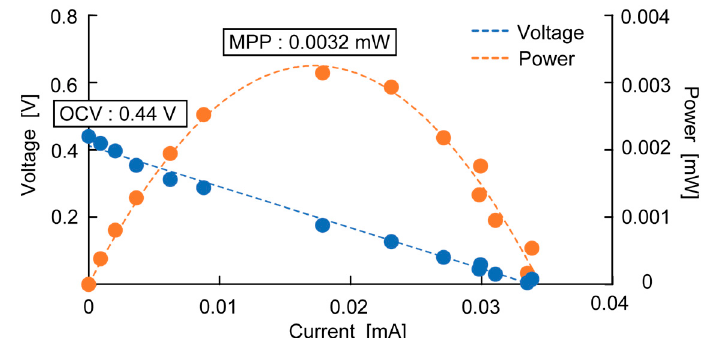
Figure 4. Typical measurement result of OCV and MPP. OCV is where the voltage is at its maximum, and MPP is where the power is at its maximum.